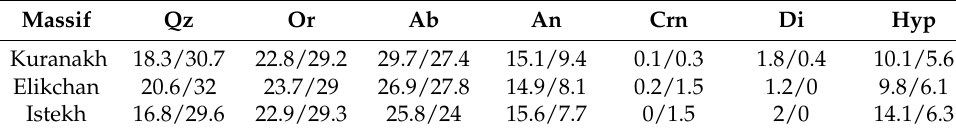
Table 3. Average normative composition (%) of granodiorites/granites. Massif Qz Or Ab An Crn Di Hyp